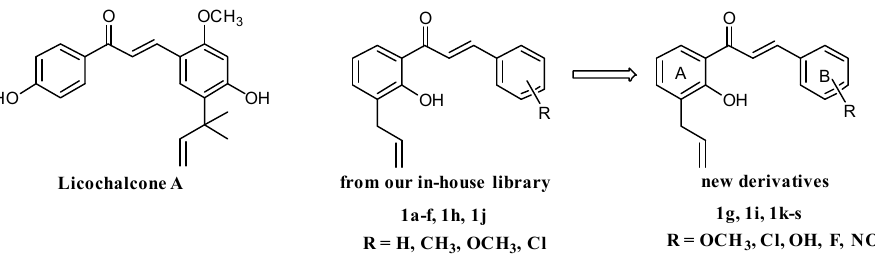
Figure 1. Design of the studied compounds.